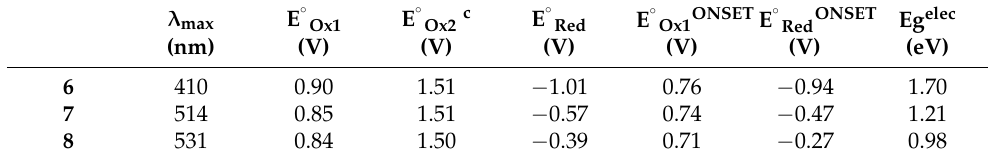
Table 1. Spectroscopic a and electrochemical b data for phenothiazine-based chemosensors 6 – 8 .